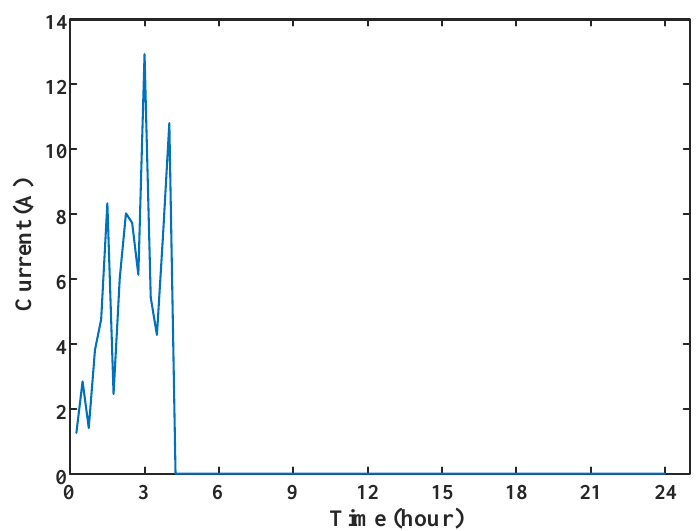
Figure 13. User’s actual load current curve on the day.